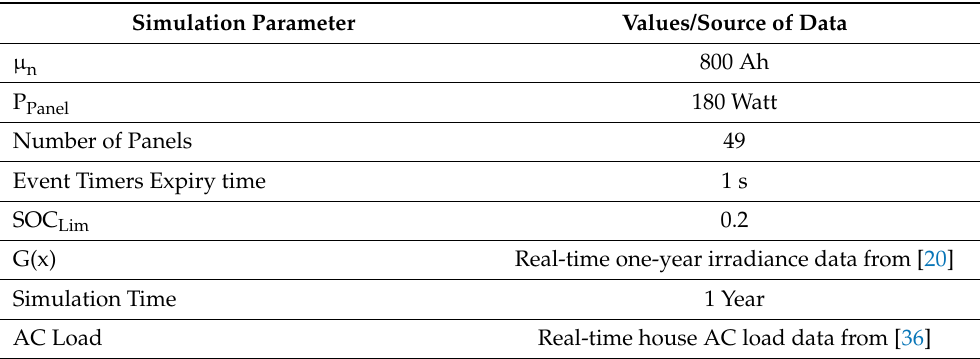
Table 3. Table 3. Simulation parameters and settings.